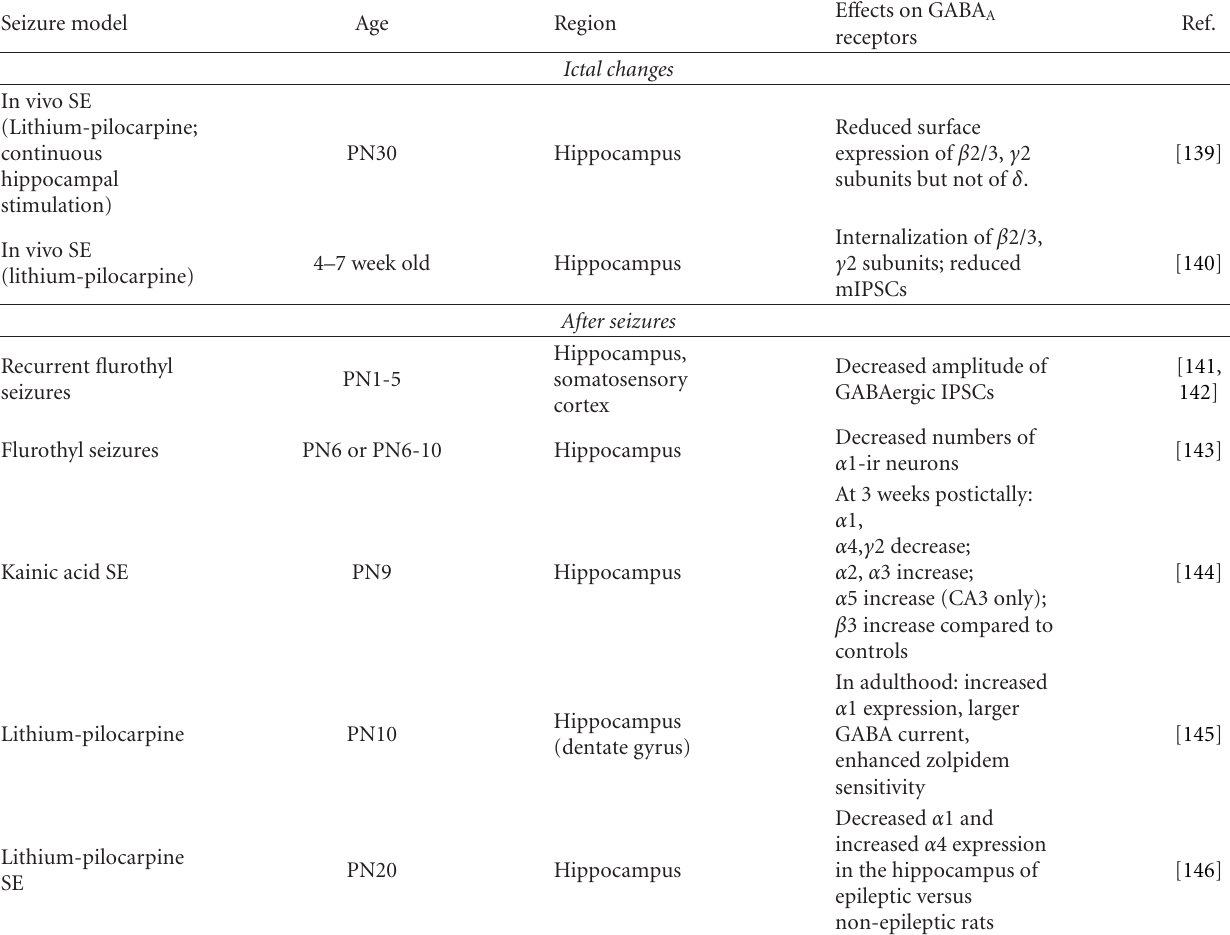
Table 3: E ff ects of early life seizures on GABA A receptors and currents in